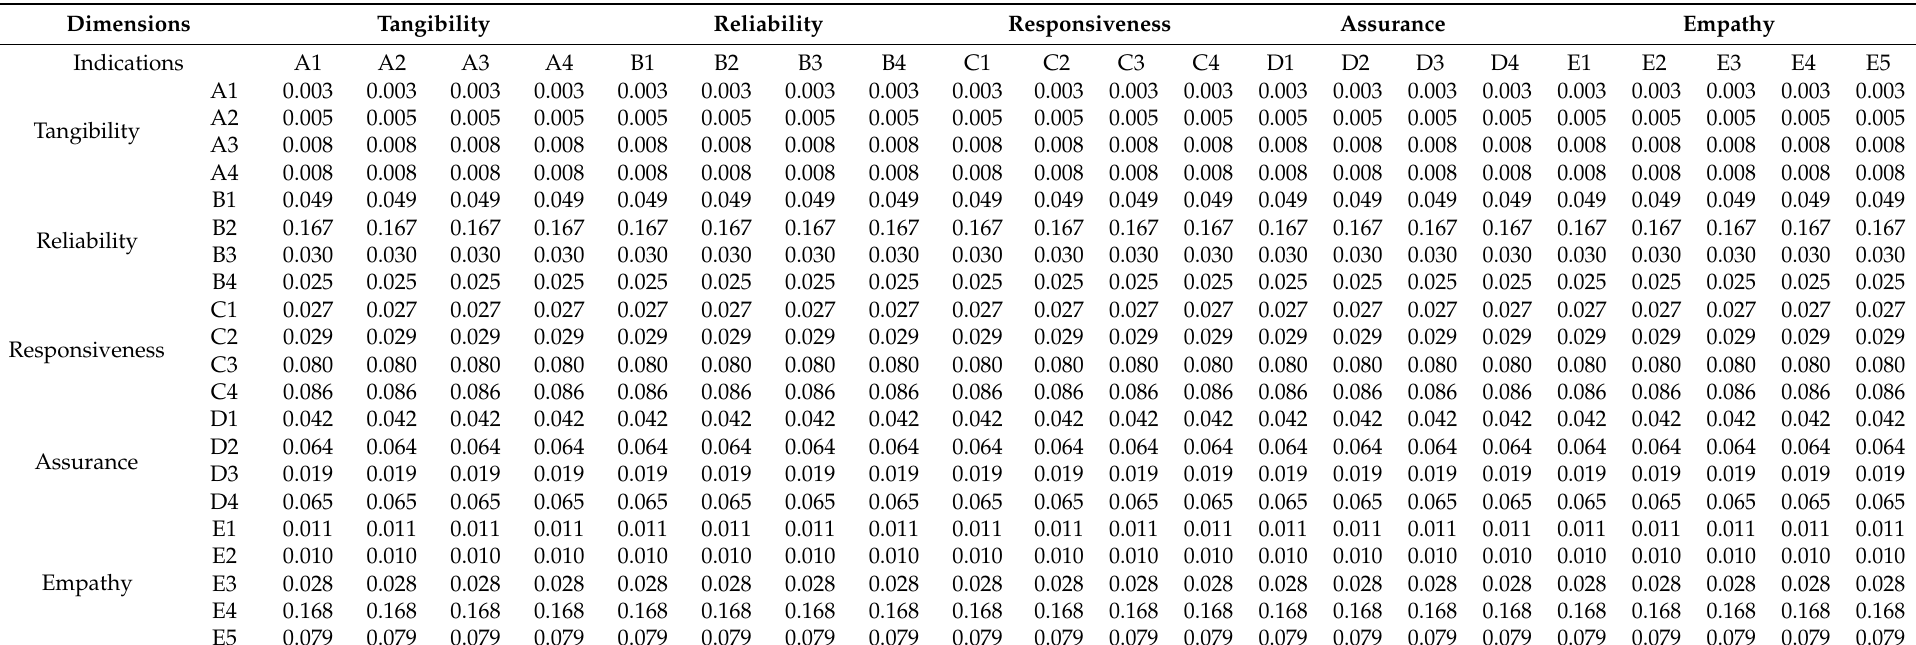
Table 6. The super matrix of comprehensive service providers’